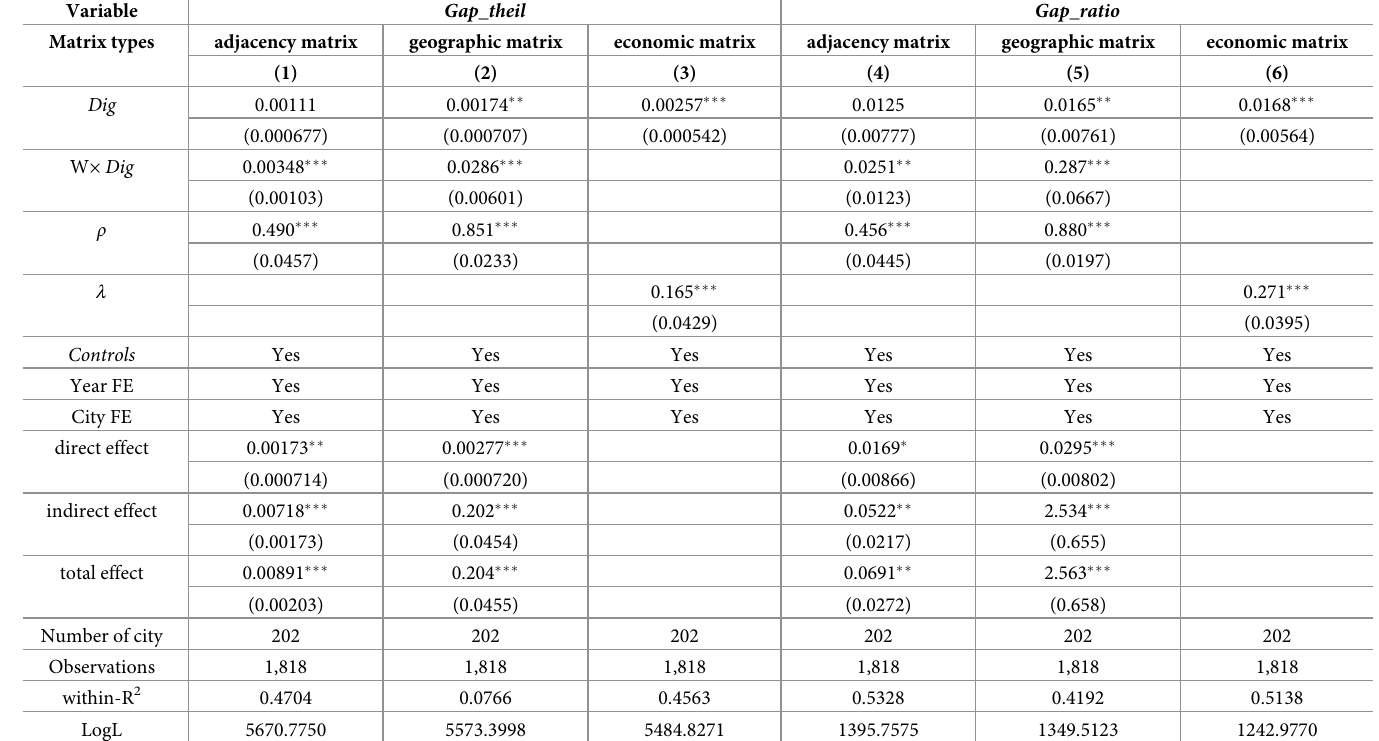
Table 8. Estimated results of spatial spillover